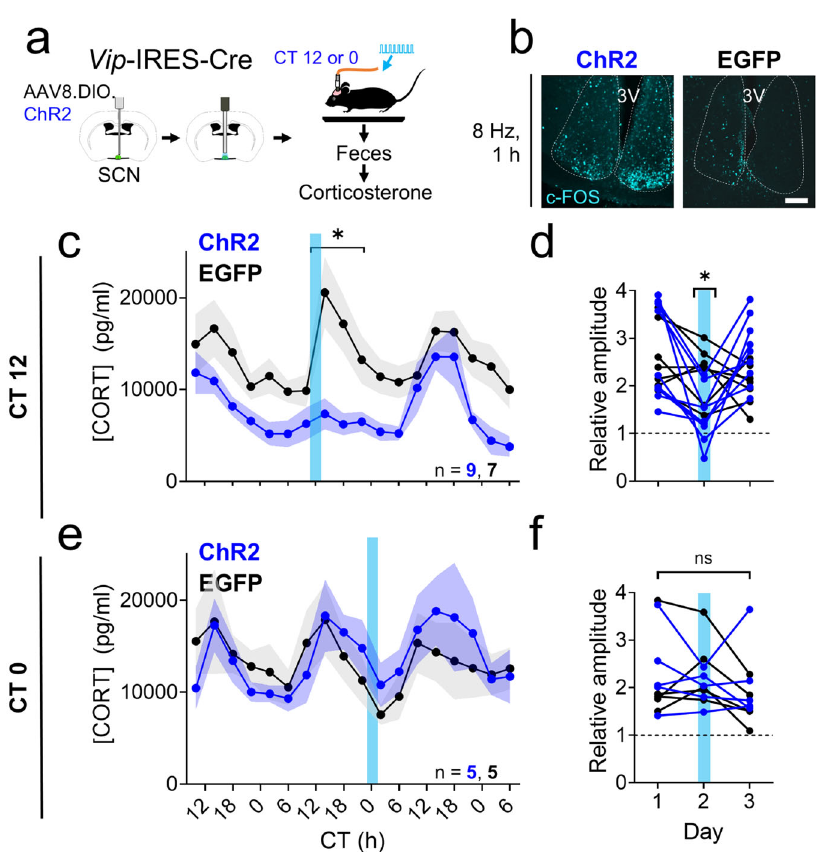
Fig. 4 Acute activation of SCN VIP neurons blunts circadian rhythms in corticosterone depending on the time of day of stimulation. a Schematic for concurrent SCN stimulation and fecal corticosterone collection. b c-FOS immunoreactivity ( n = 4 replicates, cyan) after SCN stimulation at CT (circadian time) 12 in Vip Cre/ + + ChR2 (ChR2, left) and Vip Cre/ + + EGFP (EGFP, right) mice. 3V third ventricle. Scale bar = 100 µ m. c Corticosterone rhythms over three days in EGFP (black, n = 7) and ChR2 mice (blue, n = 9). Lines and shading depict mean ± SEM. Blue bar, time of optogenetic stimulation (8 Hz, 10 ms, 470 nm, 2 h from CT 11-13). Mixed-effects model with post-hoc Sidak ’ s multiple comparisons test, * p < 0.001. d The relative amplitude of the corticosterone rhythm (the ratio of the average level at CT 10-18 divided by the average at CT 22-6) in EGFP (black) and ChR2 (blue) mice on each day of collection. Blue line depicts the day of optogenetic stimulation from CT 11-13. Two-way repeated-measures ANOVA with post-hoc Sidak ’ s multiple comparisons test, p = 0.043. e Corticosterone rhythms over 3 days in EGFP (black, n = 5) and ChR2 mice (blue, n = 5). Lines and shading depict mean ± SEM. Blue bar, time of optogenetic stimulation (8 Hz, 10 ms, 470 nm, 2 h from CT 23-1). Mixed-effects model, p = 0.929. f The peak-trough amplitude of the corticosterone rhythm in EGFP (black) and ChR2 (blue) mice on each day of collection. Blue line depicts the day of optogenetic stimulation from CT 23-1. Two-way repeated-measures ANOVA, p = 0.054. Source data are provided as a Source Data fi